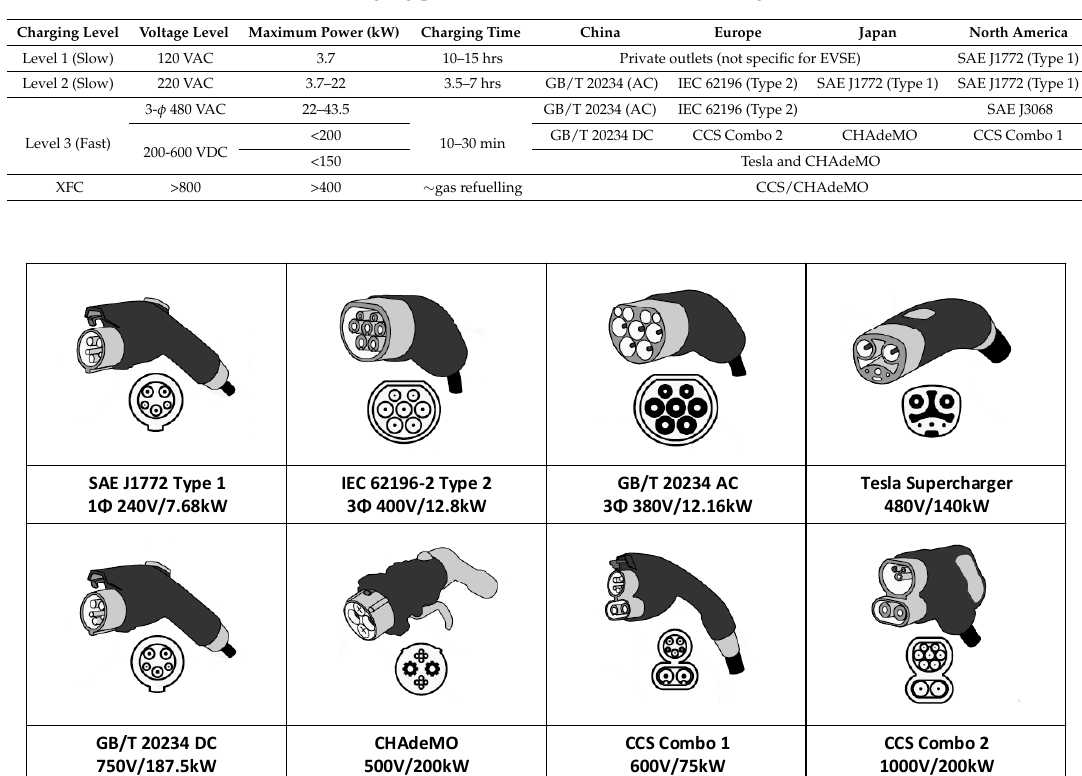
Table 2. Charging power levels, standards and configurations.